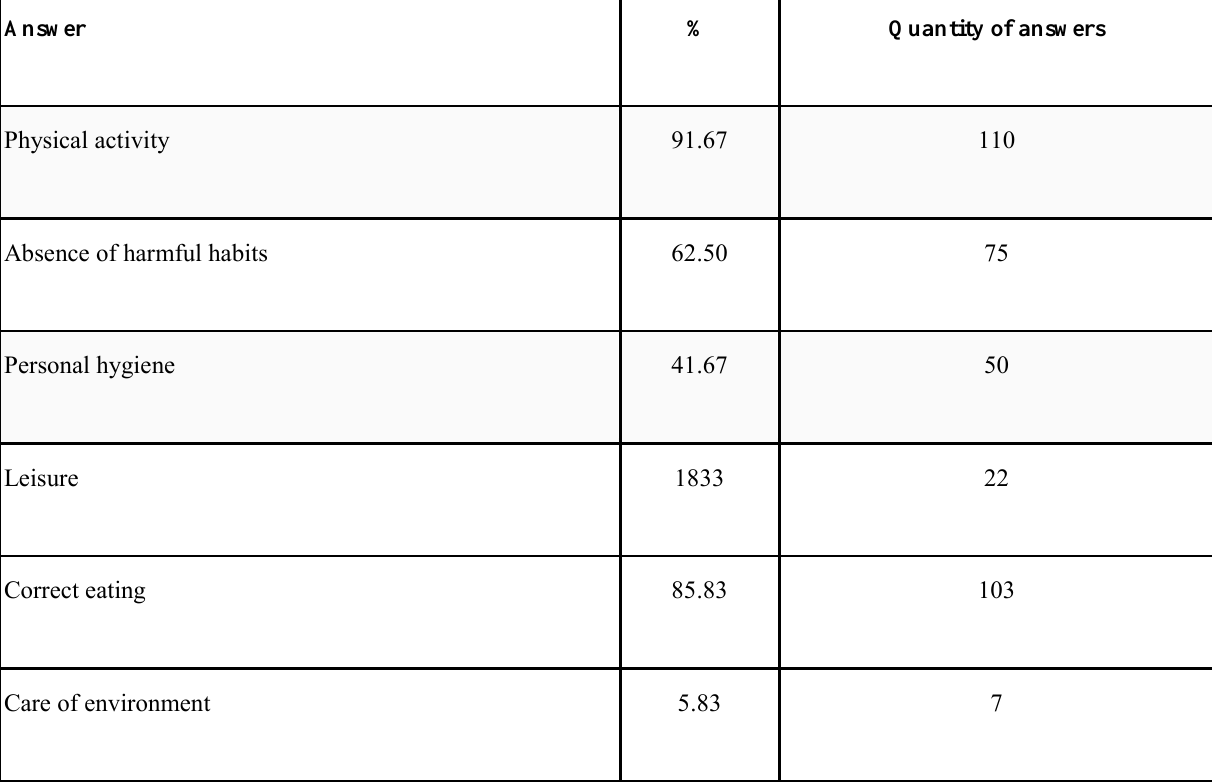
Questioning results of Polish students (by data of